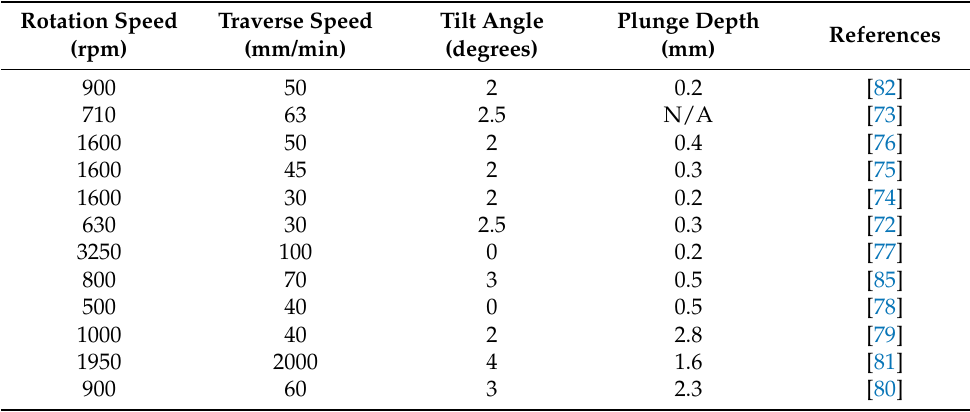
Table 5. Optimum FSW parameters used to join metals to polymers. Rotation